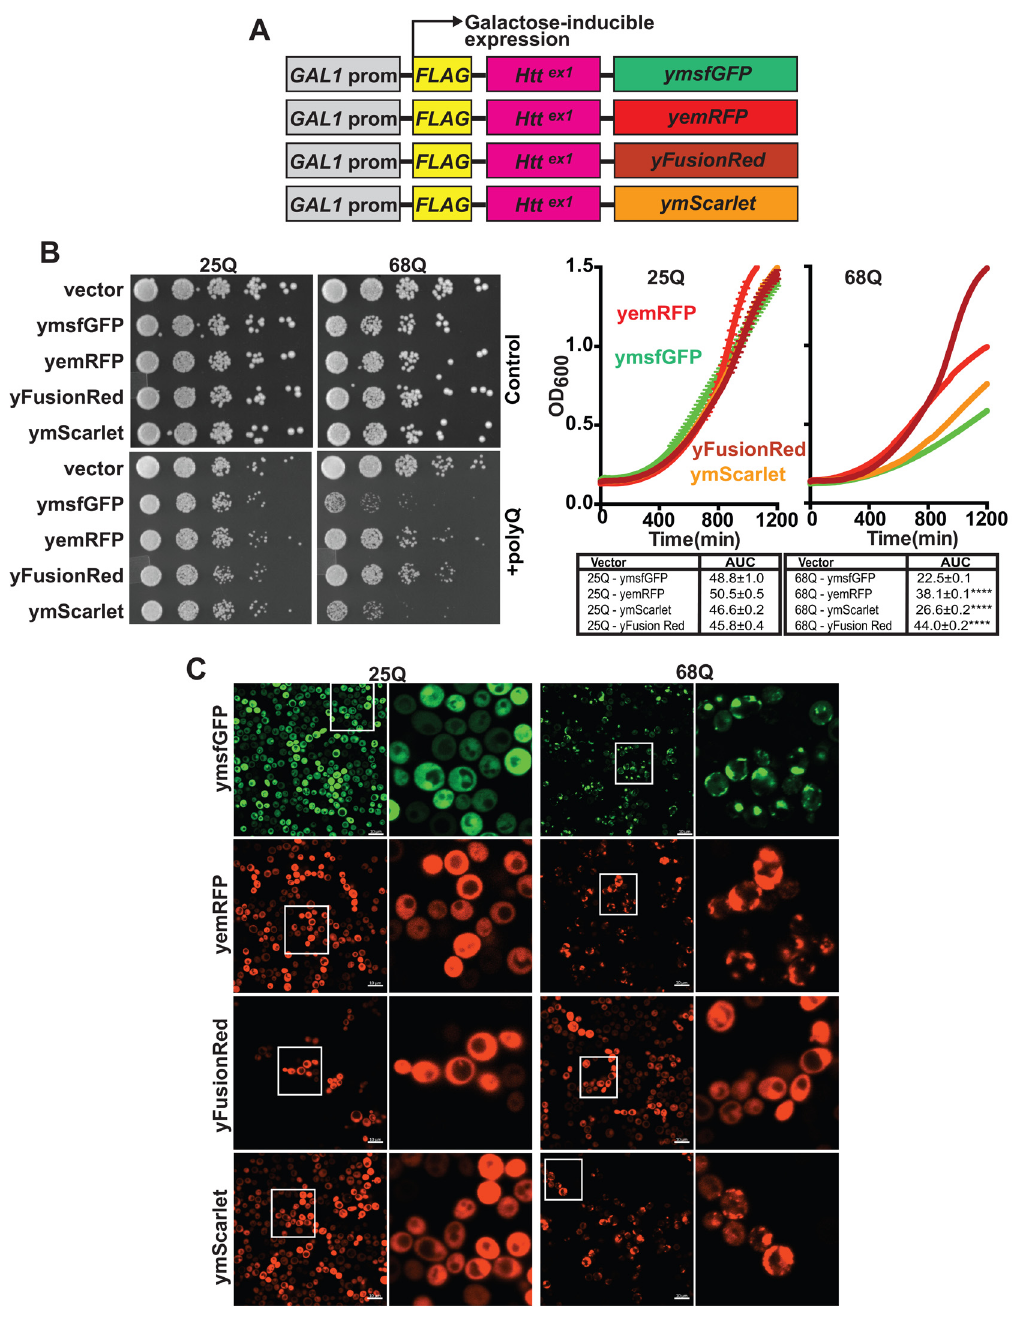
Figure 2. Unlike yFusionRed, ymScarlet displays a toxic polyQ phenotype similar to ymsfGFP. ( A ) Scheme of vectors encoding fluorescent Fluorescent proteins (FPs) were cloned in frame with FLAG-Htt ex1 into a centromeric vector carrying a GAL1 inducible promoter. ( B ) Images of yeast growth assays on agar plates. Yeast cells carrying an empty vector or 25/68Q Htt ex1 fused to either ymsfGFP, yemRFP, yFusionRed or ymScarlet were grown to saturation overnight in glucose (control) or galactose (polyQ induced) containing media. The next days, cell concentrations were equalized to OD 0.2 and 5 fold serial dilutions of the cell suspension spotted on synthetic complete agar 600 media plates containing either glucose or galactose. Alternatively, cells were cultured in liquid media and optical densities were recorded over time to generate growth curves. The area under the curve (AUC) was calculated from 3 experimental replicates. ****p<0.0001 according to a one way ANOVA followed by a Dunnett’s multiple comparison test comparing samples to ymsfGFP-tagged fusion of the same polyQ length. ( C ) Representative fluorescent images from 3 fields of yeast cells expressing 25/68Q Htt Htt ex1 fused to ymsfGFP, yemRFP, yFusionRed or ymScarlet after overnight induction in galactose-containing